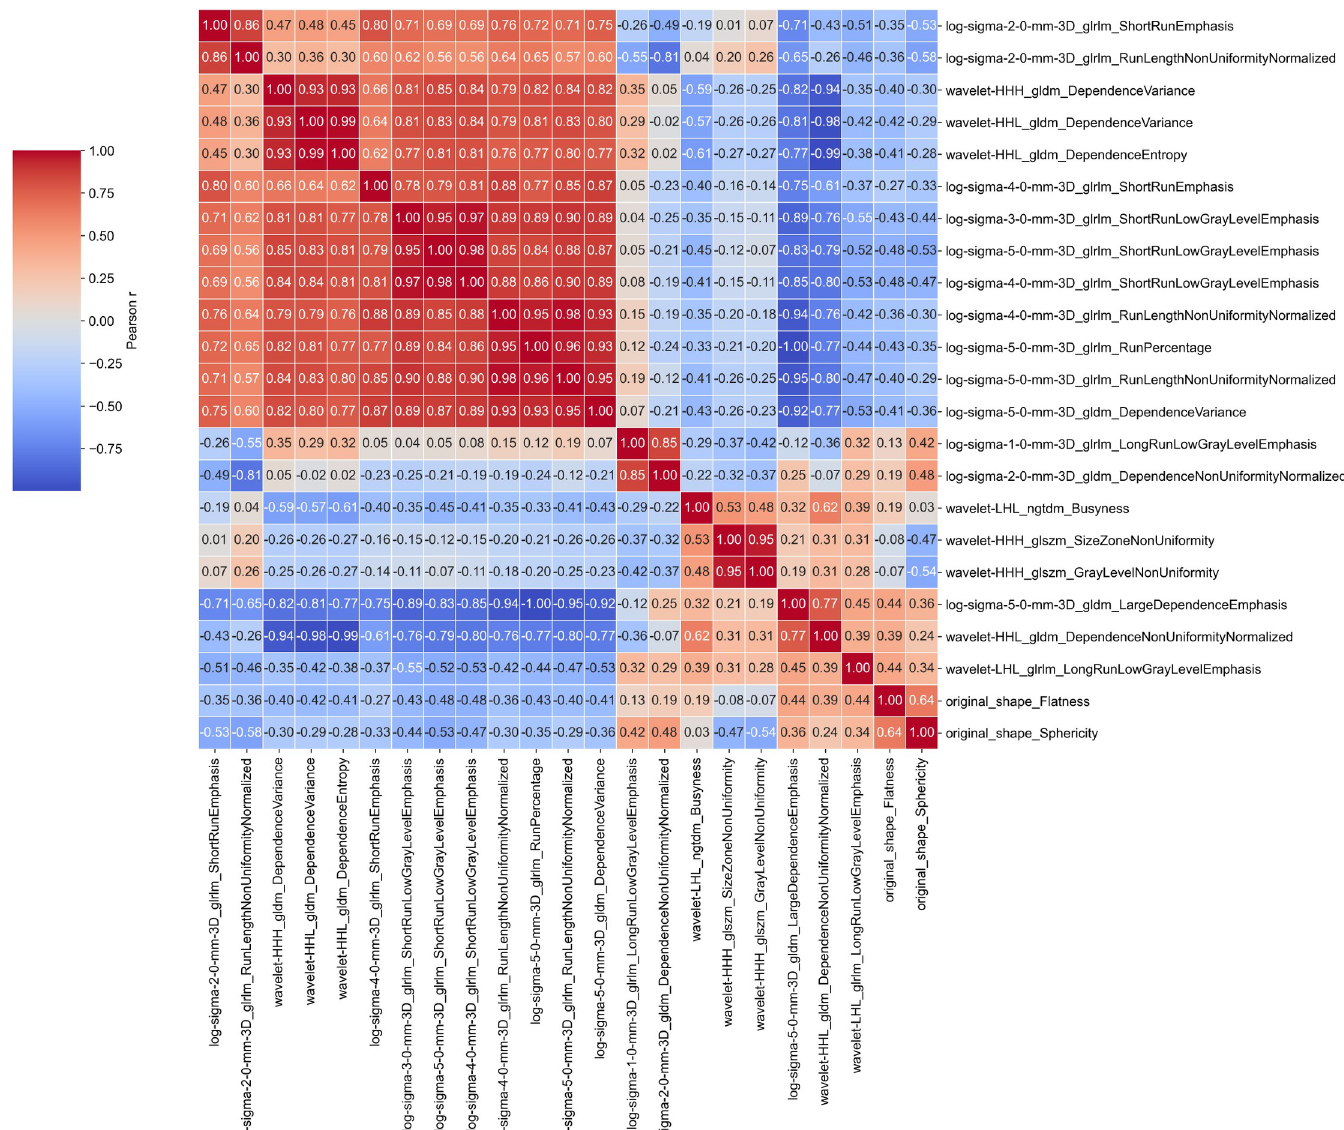
Fig 3. Correlogram of all selected radiomic features. Colors and numbers show Pearson’s correlation coefficient r of the respective feature pair.